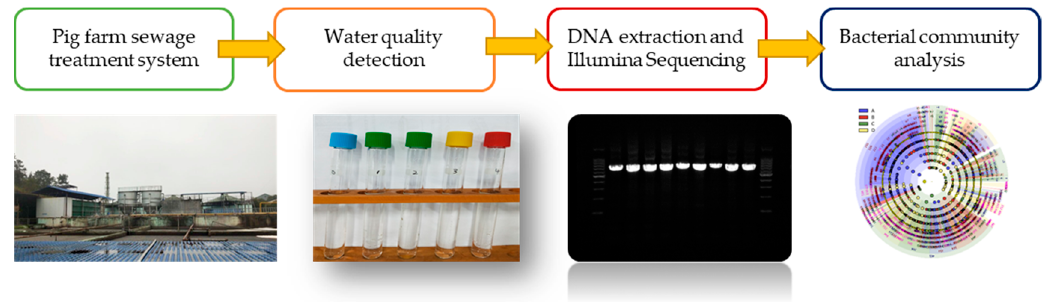
Figure 1. Schematic diagram of experimental process.